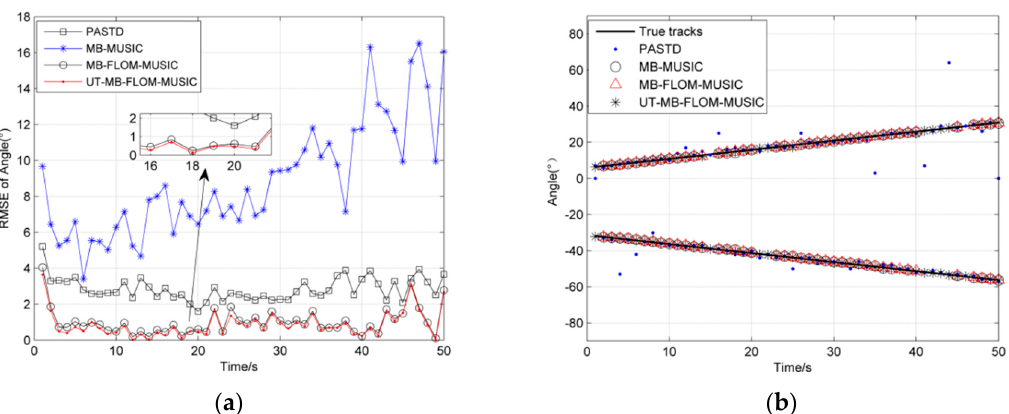
Figure 1. Root mean square error (RMSE) of angle under α = 2, L = 100 and Generalized Signal to Noise Ratio (GSNR) = 10 dB: ( a ) The RMSE of 100 MC; ( b ) source trajectory of Single MC.